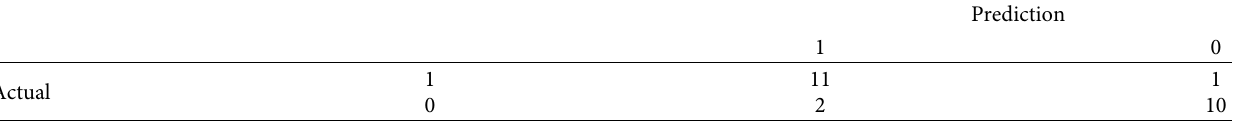
Table 5: Confusion matrix of rumor results.